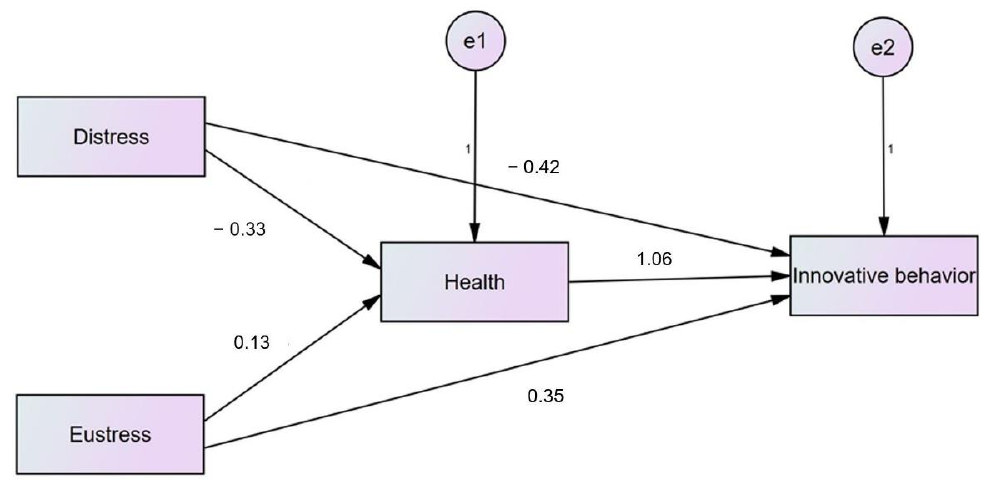
Figure 3. SEM analysis proposed model, e1 and e2 are error terms, and arrows are representing the beta values.